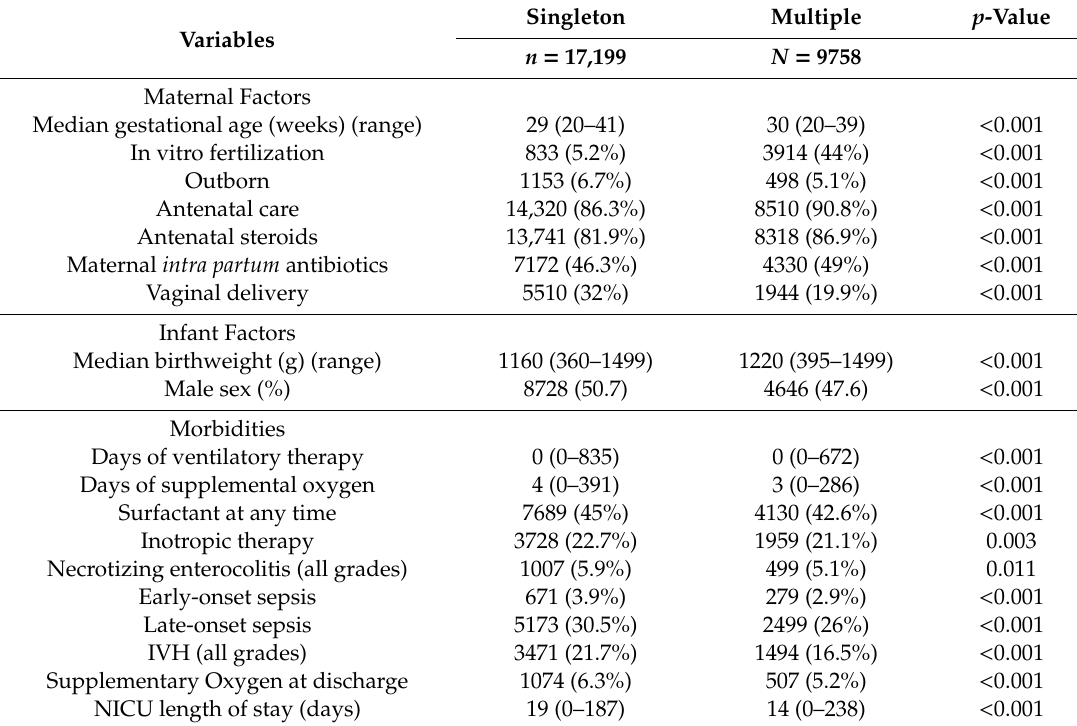
Table 2. Demographic and pathological characteristics of singletons versus